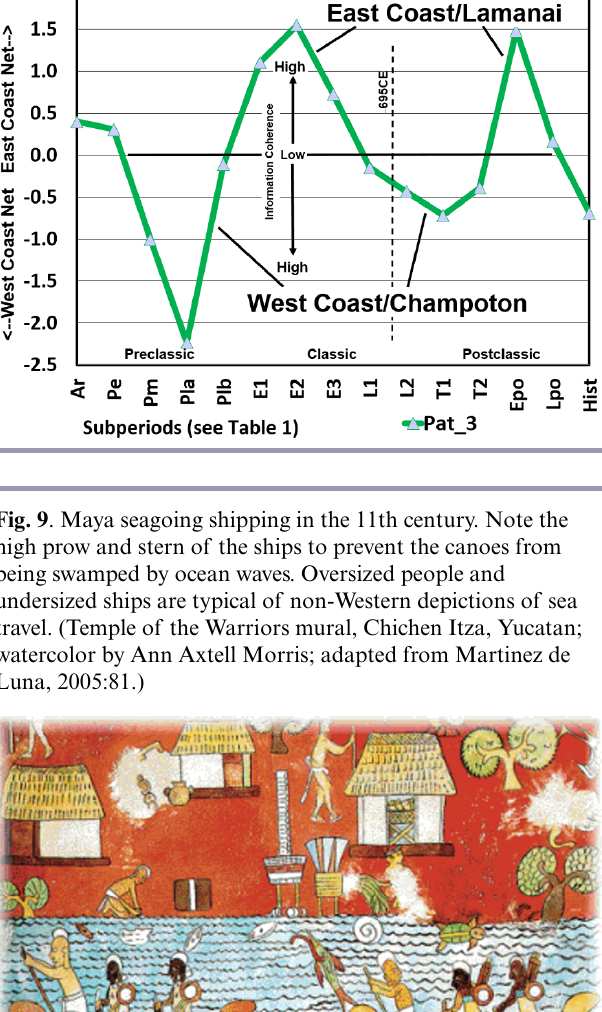
Fig. 8 . East and west coast cities follow alternating paths of networking. West coast cities (represented by Champoton) formed strong networks in the Preclassic and Late Classic to early Postclassic. East coast cities (represented by Lamanai) networked in the early Classic and early Postclassic (plotted from pattern 3, see Table 5).